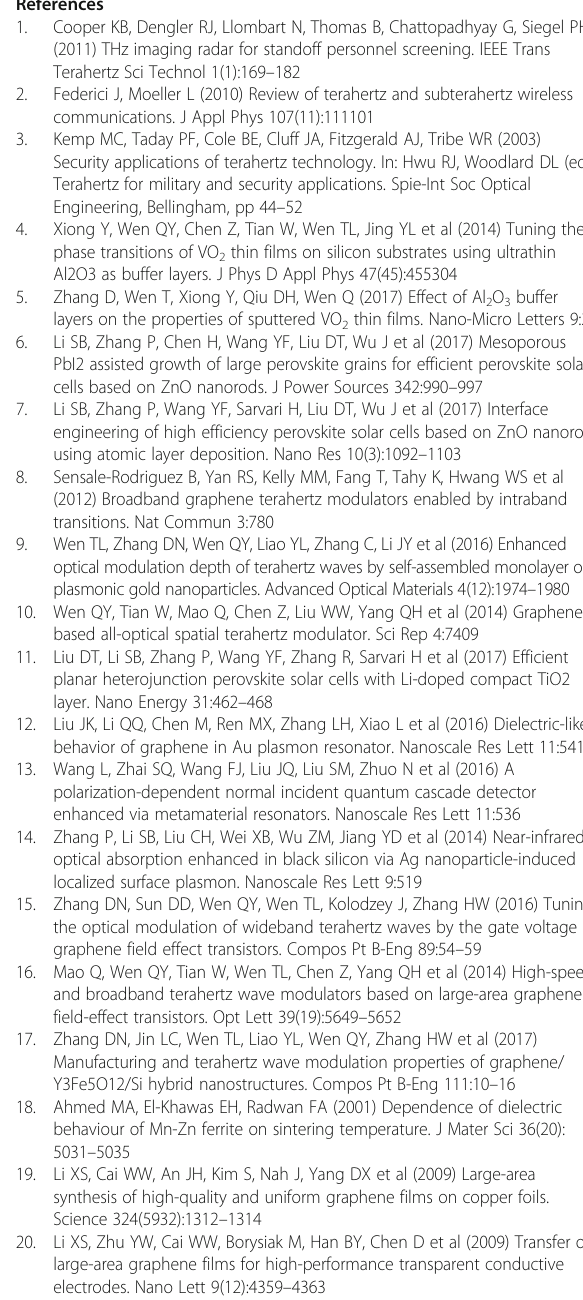
Additional file 1: Figure S1. The magnetoresistance of graphene/MnZn ferrite/p-Si heterojunctions at Vsg = − 15 V and room temperature. (DOCX 47 kb)